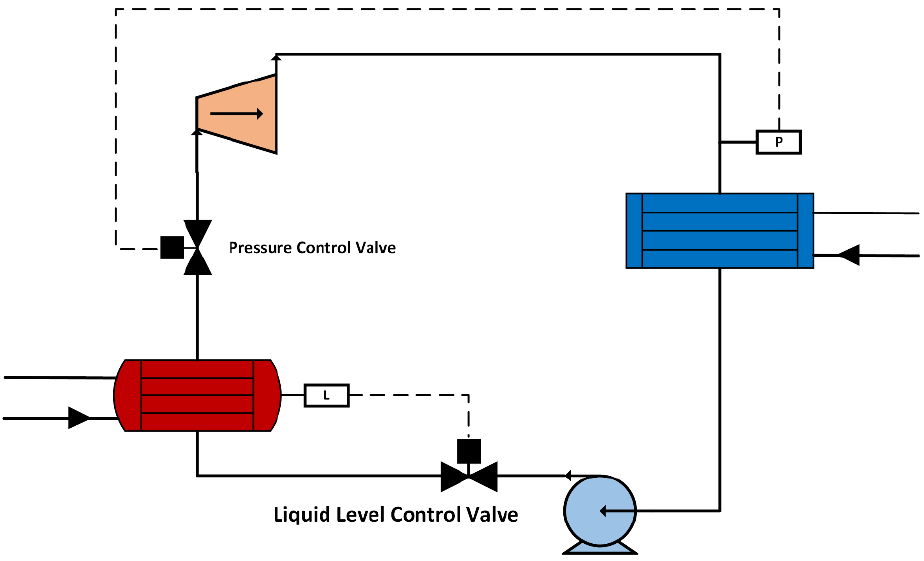
Figure 1. Flow chart of OTEC system based on ORC. Table 1. The key characteristic parameters of the OTEC system.